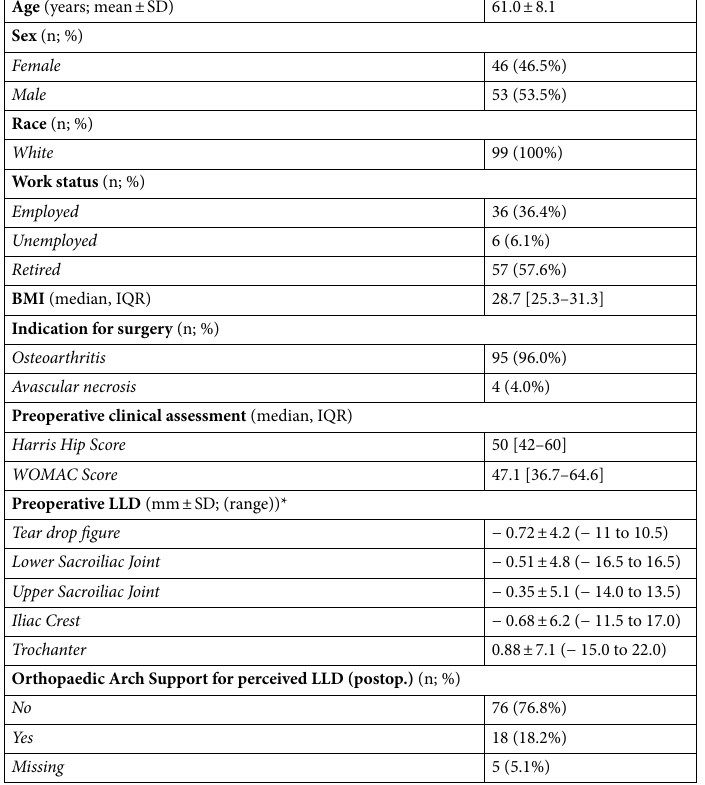
drop figure (difference: − 2.8 mm ± 0.7 mm; P < 0.001), and the iliac crest in comparison to the tear drop figure (difference: 1.8 mm ± 0.5 mm; P = 0.005), whilst there was no significant difference between the lower sacroiliac joint in relation to the tear drop figure (difference: − 0.4 mm ± 0.3 mm; P = 0.129) and the upper sacroiliac joint in relation to the tear drop figure (difference: − 0.2 mm ± 0.3 mm; P = 0.495).